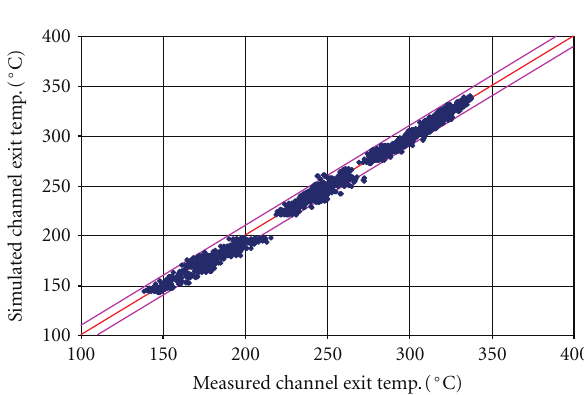
Figure 5: Comparison of calculated and measured channel outlet temperatures for a mixing coe ffi cient of 0.06 (envelope: ± 10 ◦